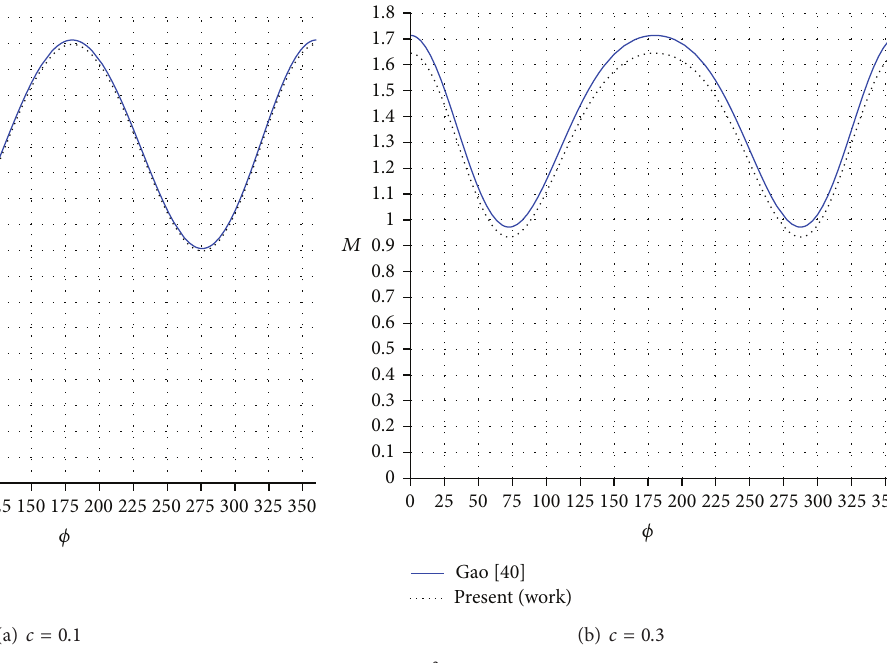
Figure 5: The 𝑀(𝜙) for 𝑓(𝜁) = 𝜁 + 𝑐𝜁 2 at different 𝑐 .